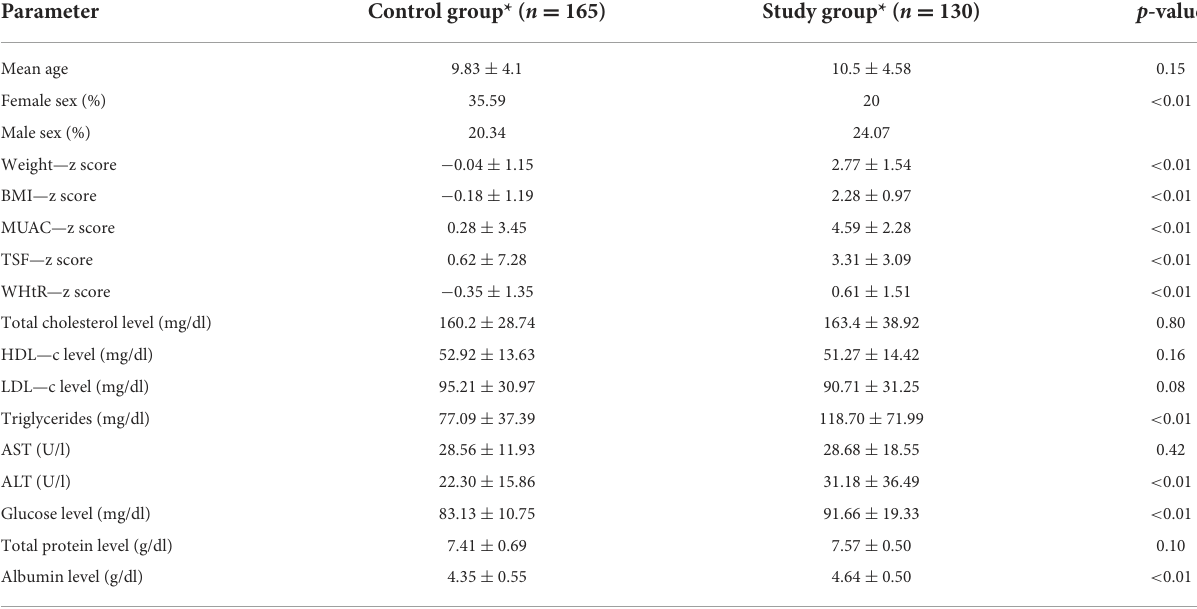
TABLE 1 Comparison of demographic, anthropometric, metabolic, and paraclinical data of the study population.